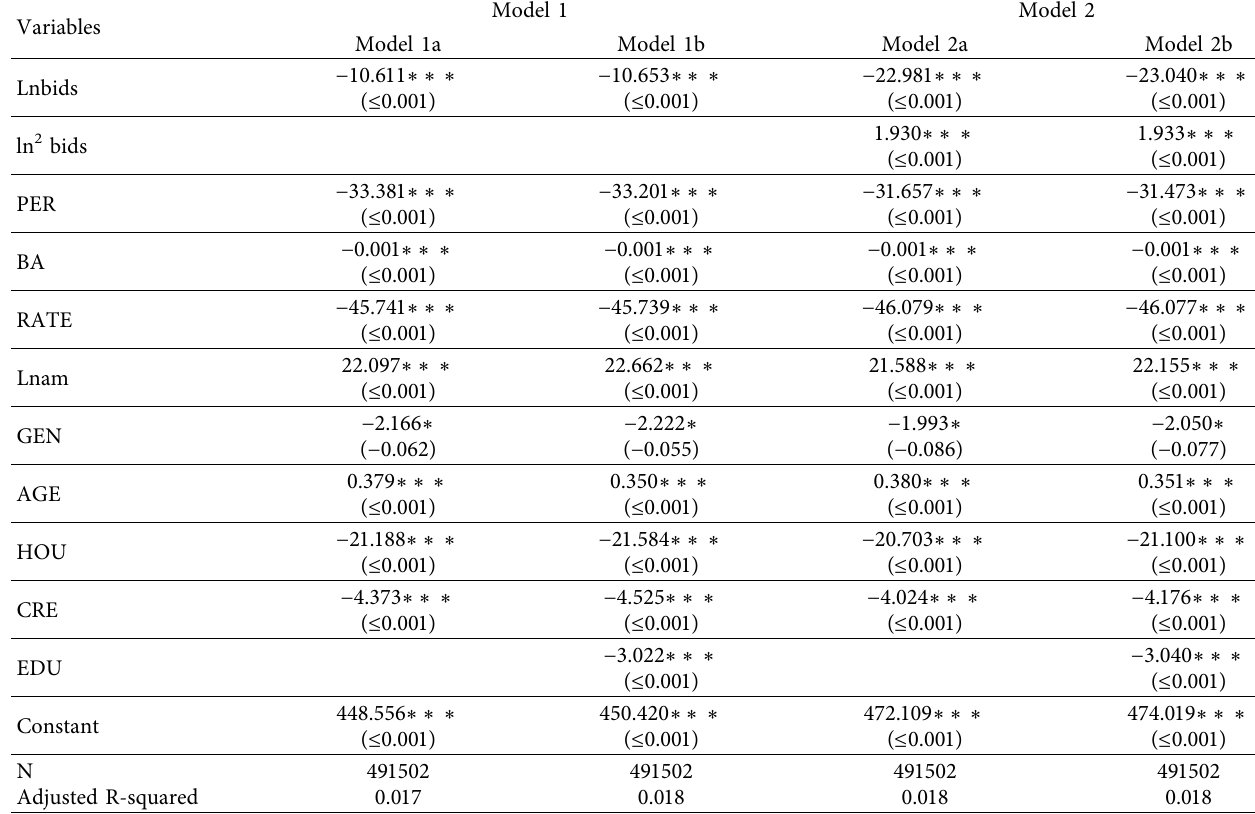
Figure 1: The time distribution of bid according to minutes. This figure illustrates the evolution of bid numbers measured in minute degree. The x -axis denotes the time, and the y -axis denotes its magnitude. Table 6: Existence of investor herd